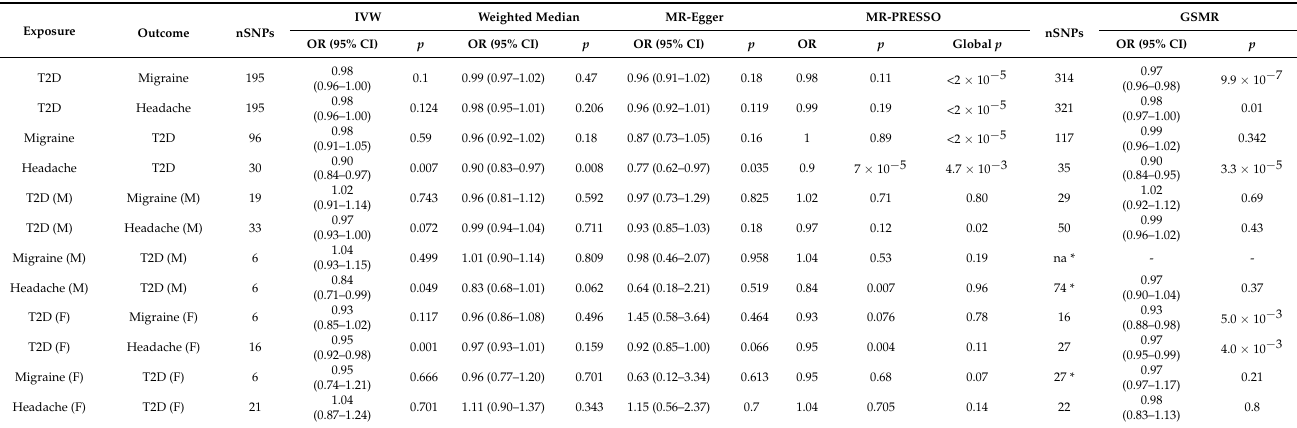
Table 9. Results of the Mendelian randomisation analyses between migraine and headache with T2D using combined and sex-stratified summary-level GWAS